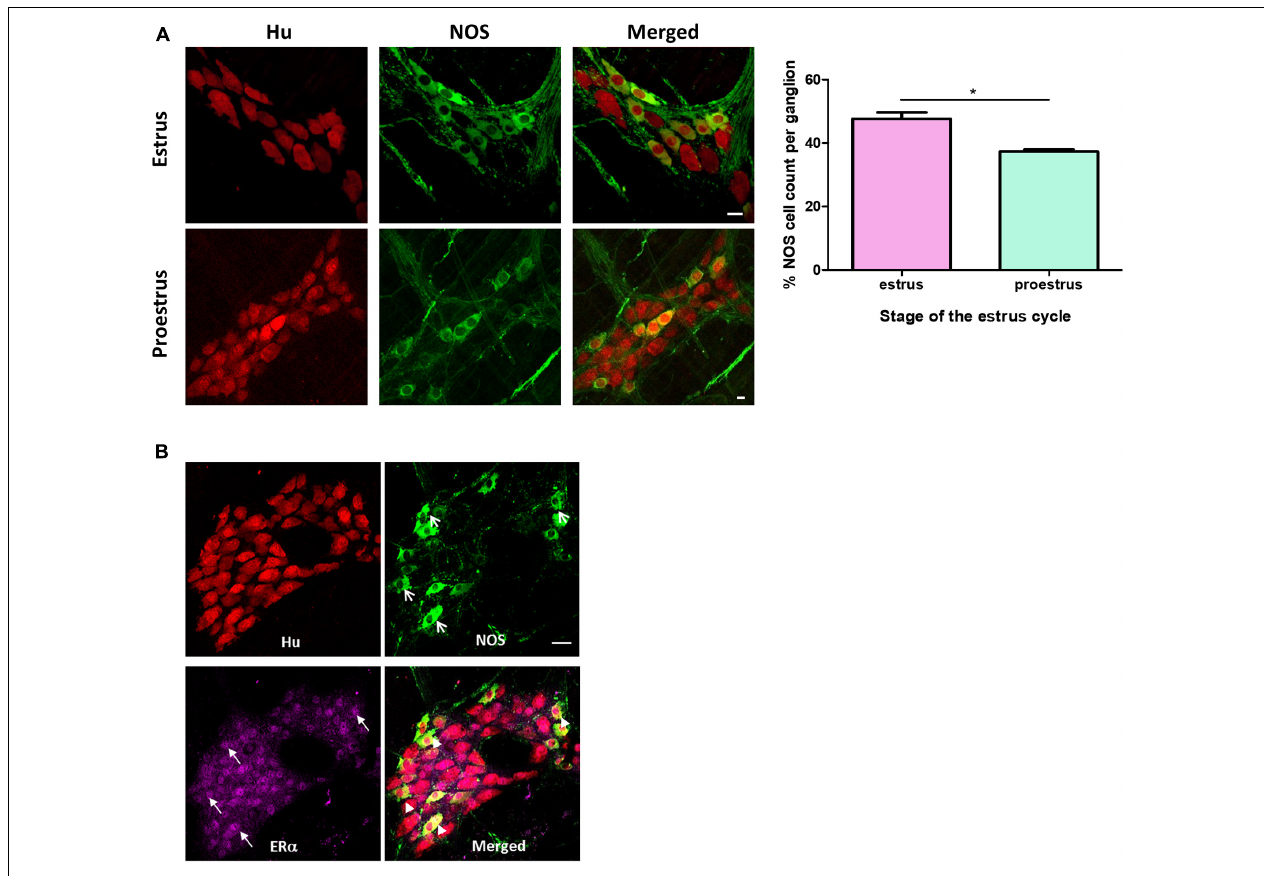
FIGURE 2 | (A) Immunofluorescence histochemical double-staining of the whole-mount preparations of the mouse colon. Estrus myenteric neurons had a significantly greater number of NOS expressing neurons compared to proestrus myenteric plexus (estrus 48 ± 2% and proestrus 39 ± 1%, n = 3, p = 042 one-way ANOVA). The pan neuronal marker Hu is shown in red and NOS expressing myenteric neurons in green. Scale bar = 20 µ m. (B) Co-labeling of NOS neurons with estrogen receptor alpha in a randomly selected female mouse. Whole mounts of myenteric ganglia showing co-labeling of Hu (red), NOS (green), and ER α (magenta). ER α is expressed in the majority of nuclei of myenteric neurons (closed arrows). Arrowheads indicate myenteric neurons co-labeled with NOS and ER α . Scale bar = 30 µ m. * p <